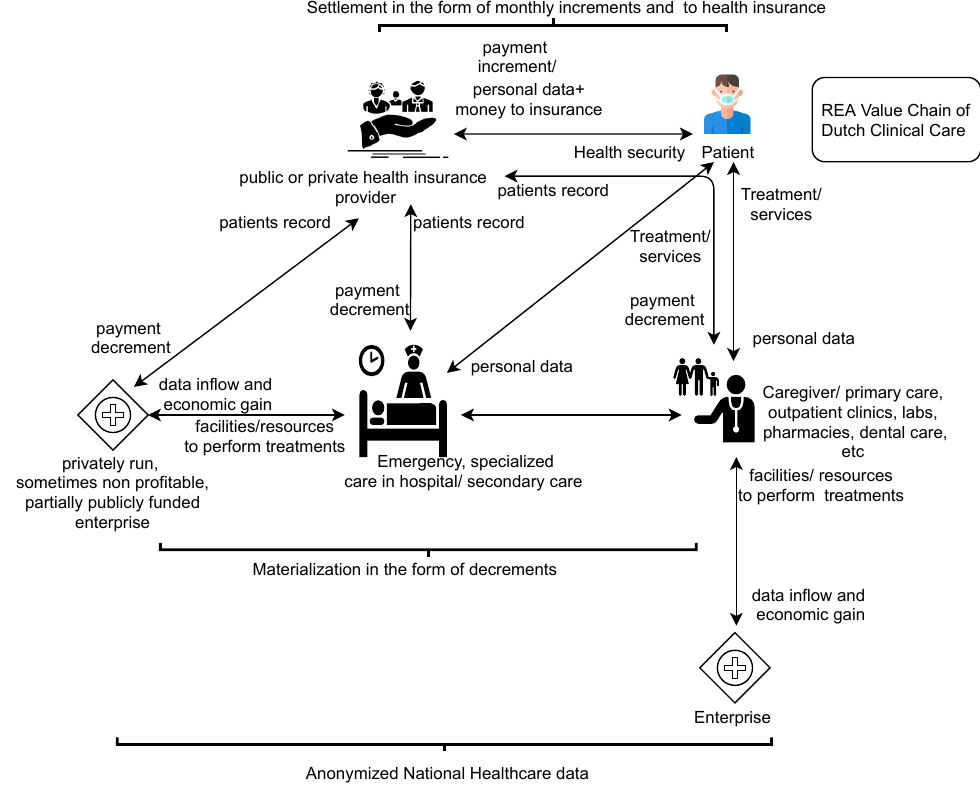
Figure 8. Financial gain/loss of healthcare enterprises and healthcare metadata